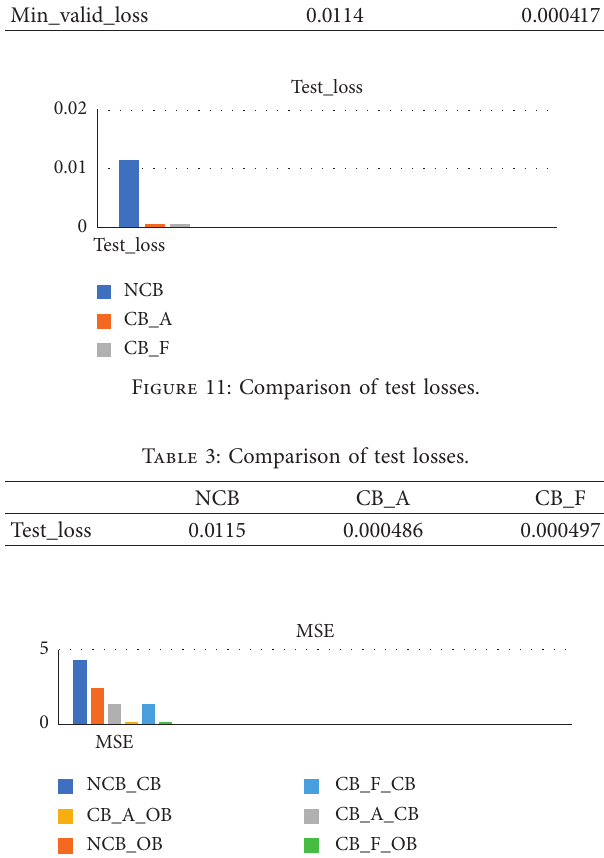
Figure 12: MSE comparison.